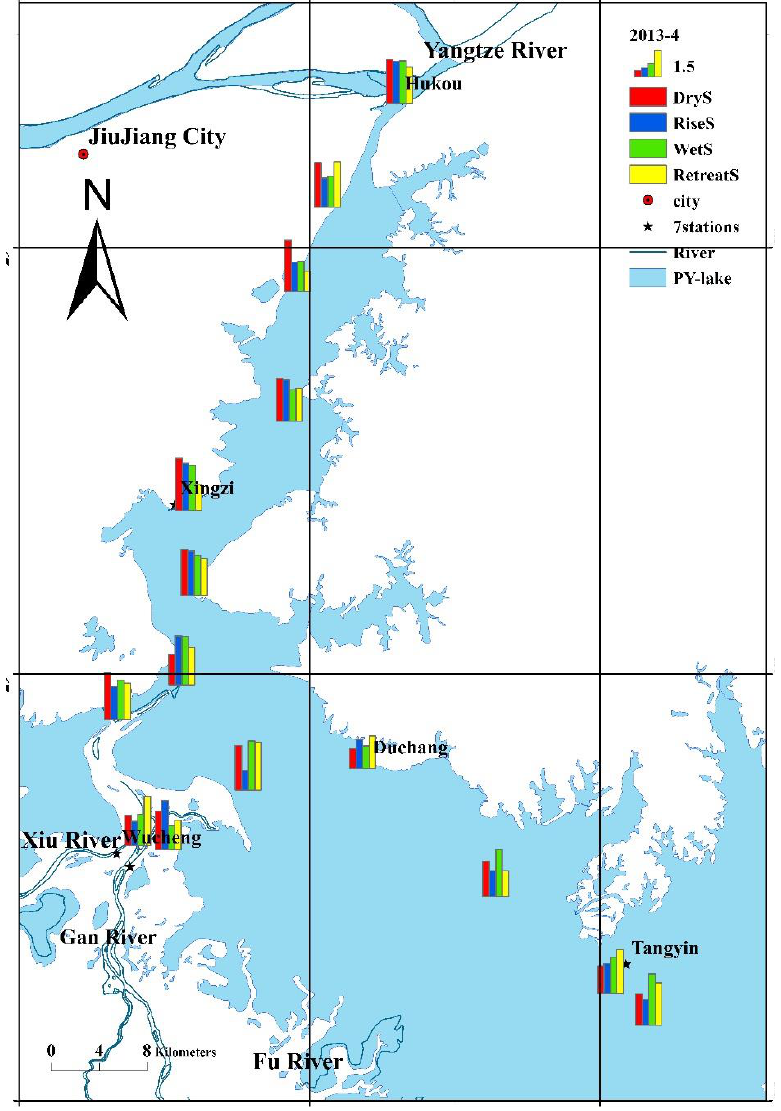
Figure 5. Aquatic ecosystem assessment results of Poyang Lake in four seasons in 2013.